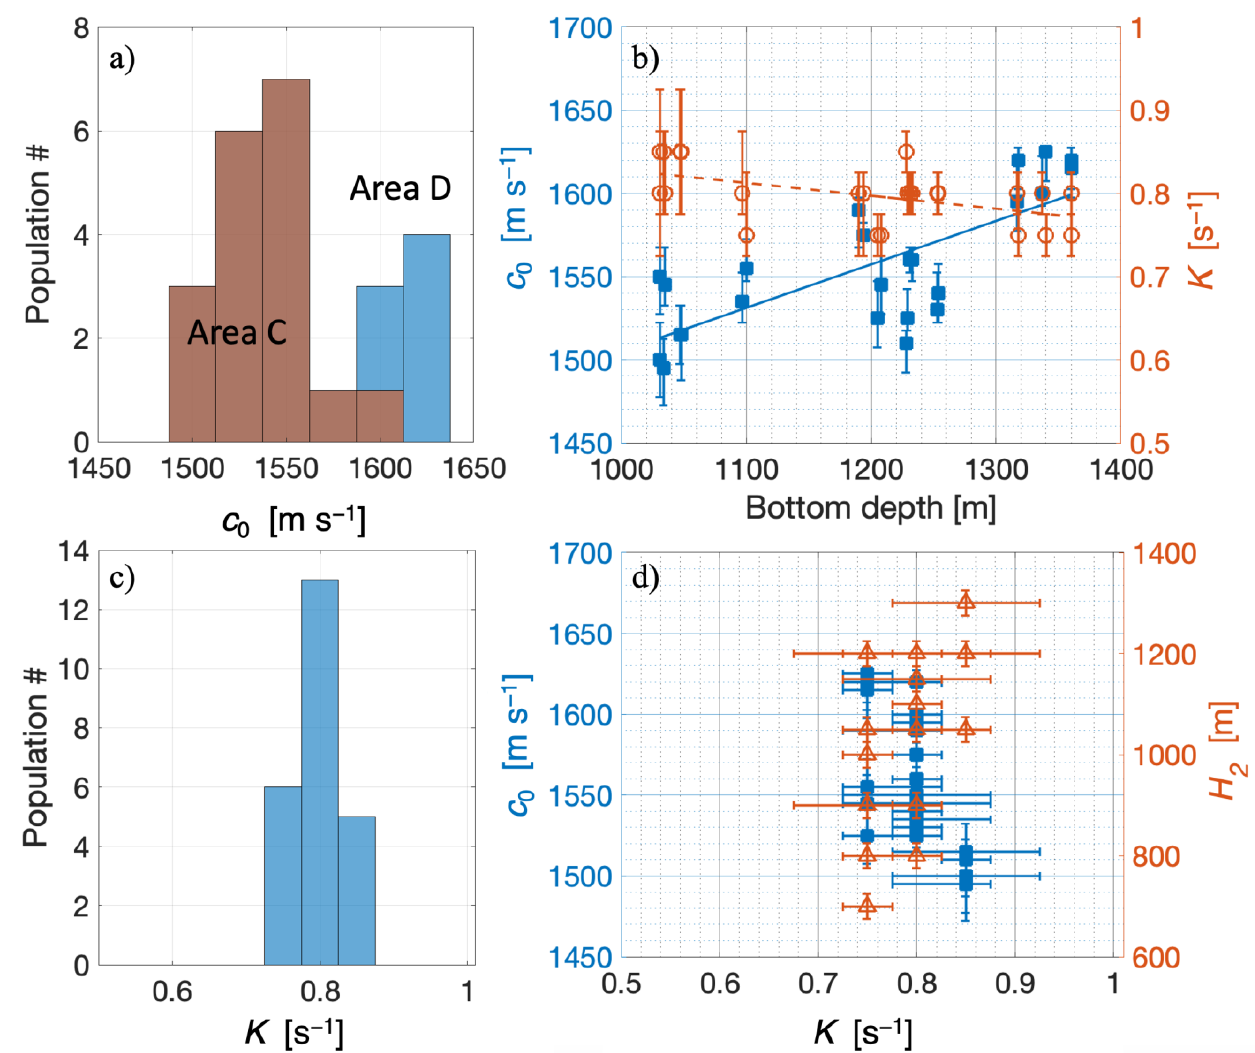
Figure 11. The distribution and dependencies of the estimated bottom parameters: ( a ) a histogram of the distribution of the seafloor sound speed c 0 values, color coded in correspondence to the shallower C (red) and deeper D (blue) parts of the study area (see Figure 12); ( b ) a cross plot of K (red circles) and c 0 (blue squares) vs. bottom depth; Solid and dashed lines represent the respective first degree polynomial fit for c 0 and K values; ( c ) a histogram of the distribution of the sound-speed gradient K values; ( d ) a cross plot of H 2 (red triangles) and c 0 (blue squares) vs. K . The vertical bars in ( c , d ) correspond to the range of the parameters associated with the normalized probability F > 0.95 of the maximum value.